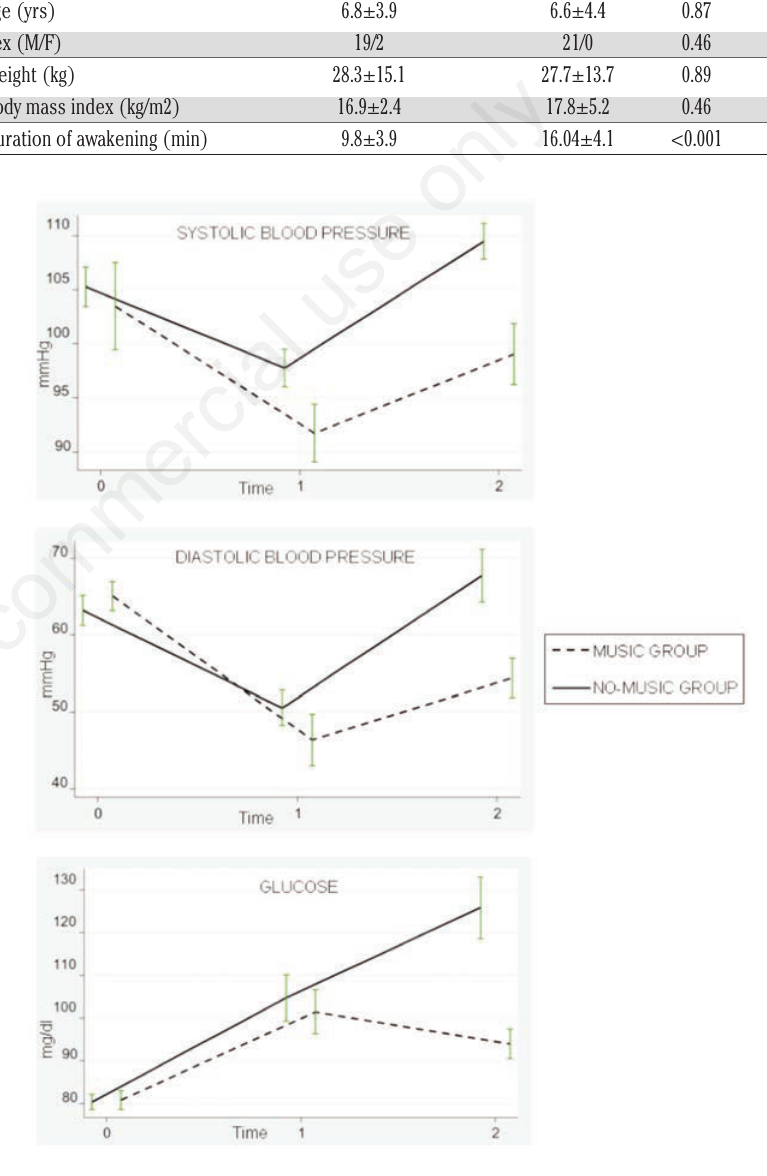
Figure 1. Comparison of the blood pressure and glucose levels at admission (Time 0), at the end of surgical procedure (Time 1) and during awakening (Time 2), in music and no- music